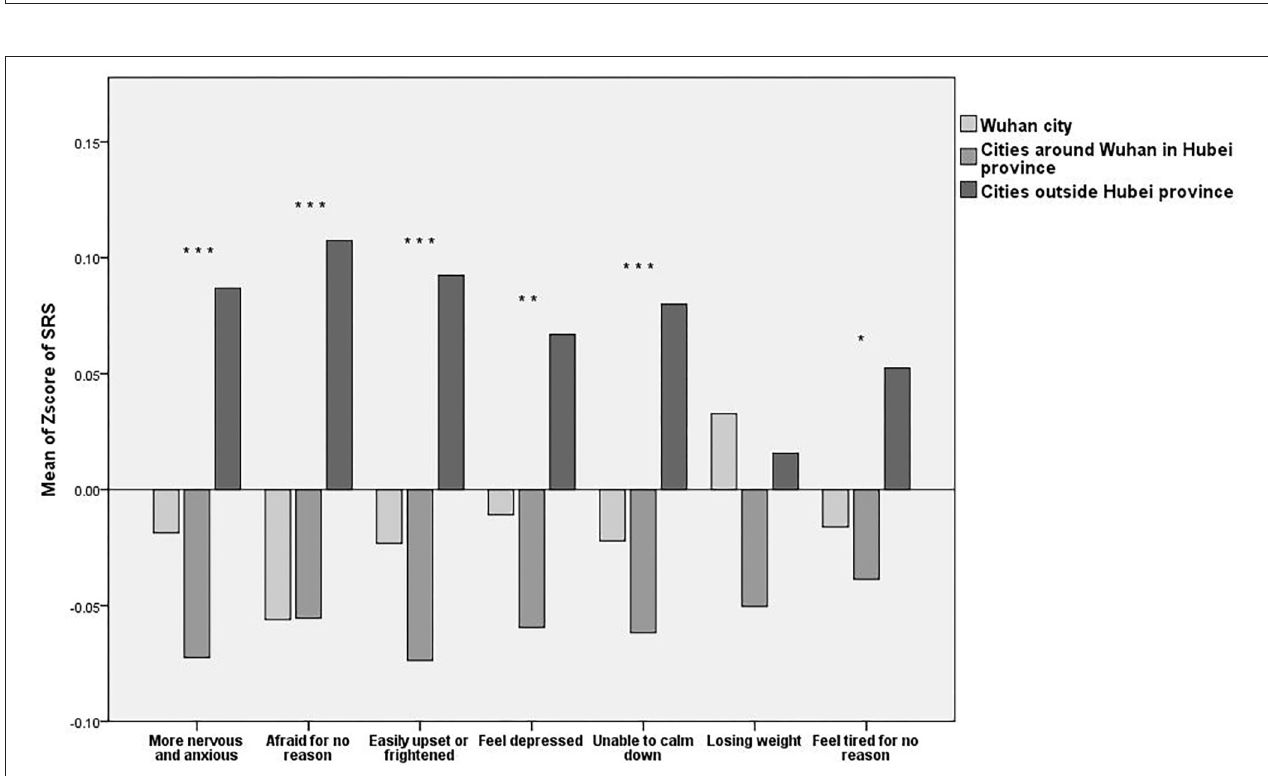
FIGURE 3 | Mean Z-scores of the Stress Response subscale (SRS). * P < 0.05, ** P < 0.01, and *** P < 0.001.